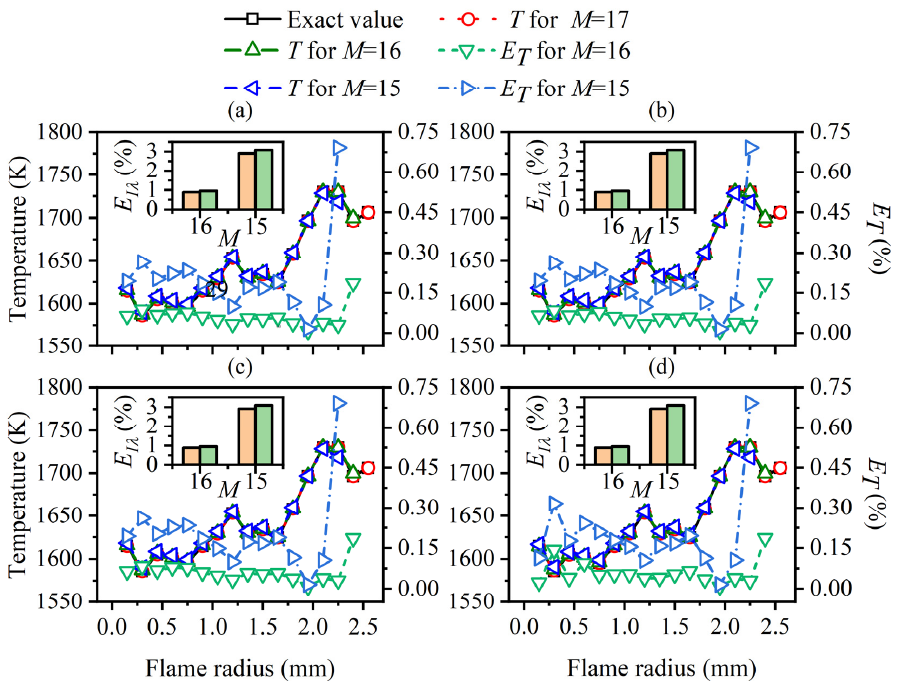
Figure 7. The reconstructed flame temperature and corresponding relative reconstruction error as well as the radiation intensity loss ratio under different cases of SNR considering the edge effect. ( a )